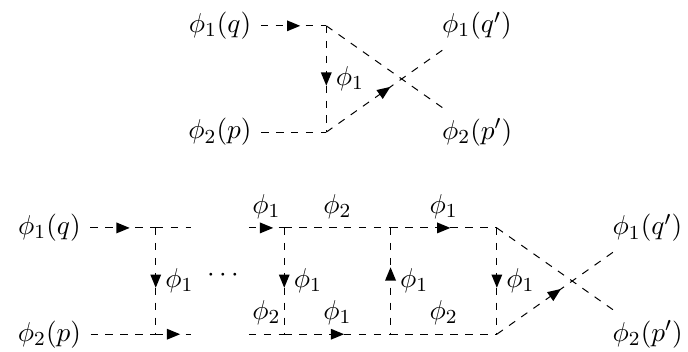
φ 1 φ 2 at tree level (above), and the corre- →